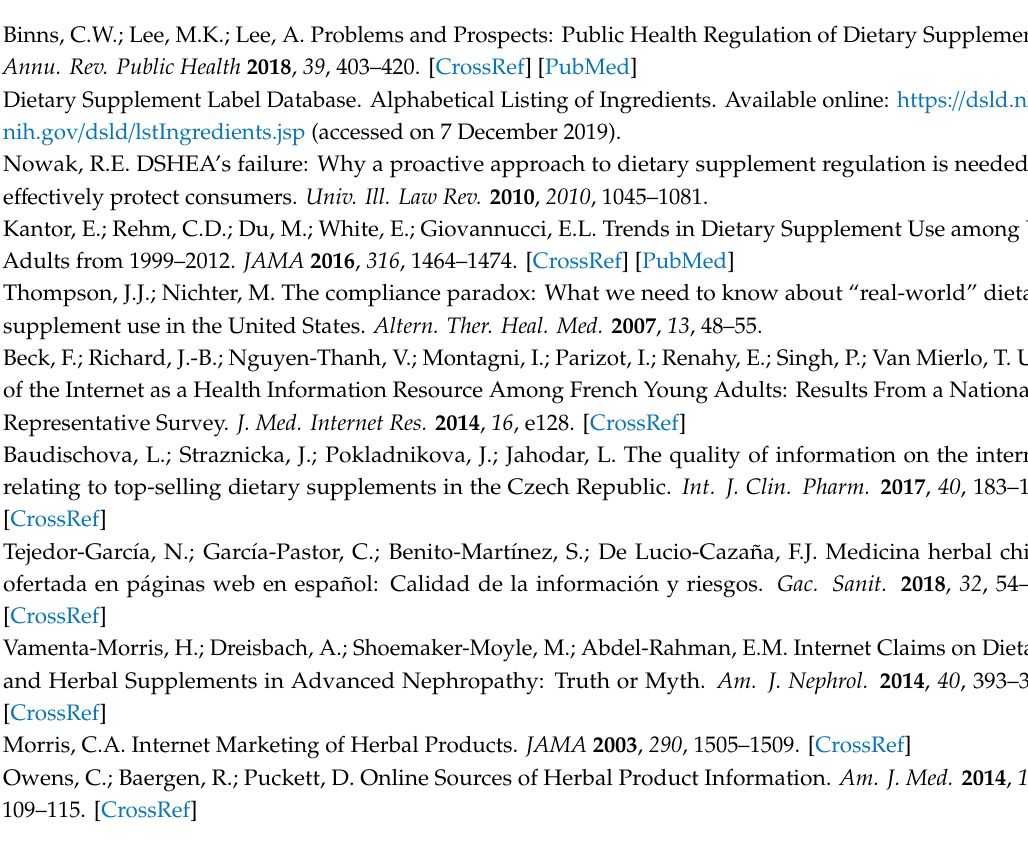
Table S1: (a) Checklist for documentation of Google Trends research. (b) The 200 topics related to dietary supplements and their categories. Alphabetical order. Table S2: Use of data generated by Google Trends. Table S3: Popularity of dietary supplement-related topics in relation to “lutein” (adjusted data; relative search volume (RSV) over time). Table S4: The 10 dietary supplement-related topics that were most frequently most popular in individual countries. Relative search volume determined by using adjusted data showing the breakdown by region (lutein + another dietary supplement-related topic). Table S5: Time series analysis of 200 topics related to dietary